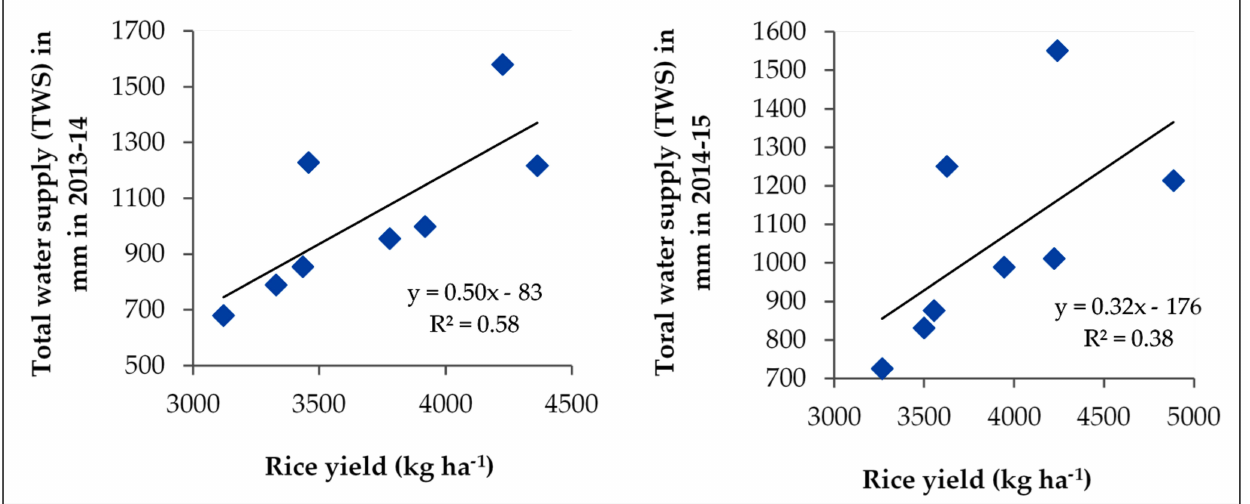
Figure 5. Relation between total water supply (TWS) and yield of